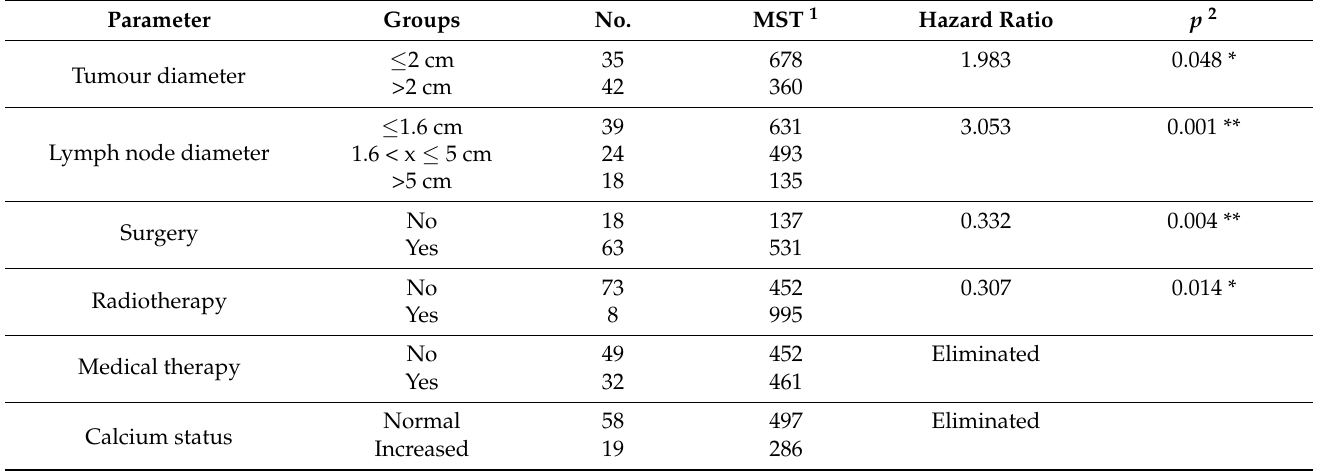
Table 2. Model generation for the effect of clinical variables on survival stratified by clinical